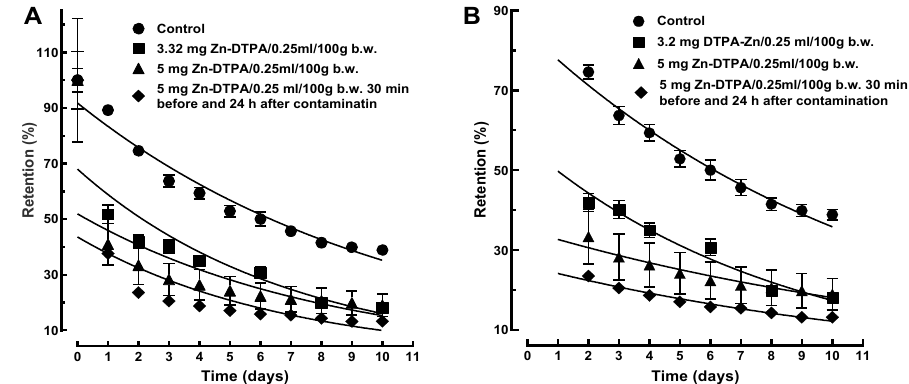
Figure 4. Mono-phasic exponential kinetics model of 65 ZnCl 2 decorporation following rapid inter- vention with Zn-DTPA in rats. ( A ) Mono-phasic kinetics model applied to the 0 to 10 days interval. ( B ) Mono-phasic kinetics model applied to the 2 to 10 days interval. Data represent means ± SEM ( n = 7).